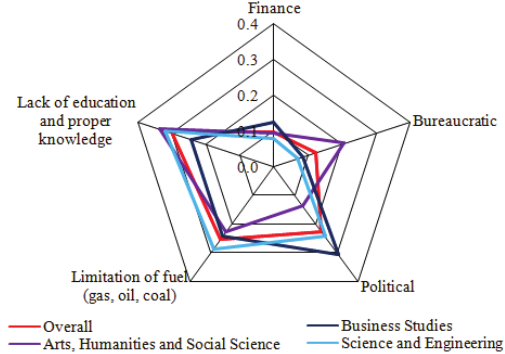
Figure A6. Responses to K8: “The main reason for energy crisis in Bangladesh is….”